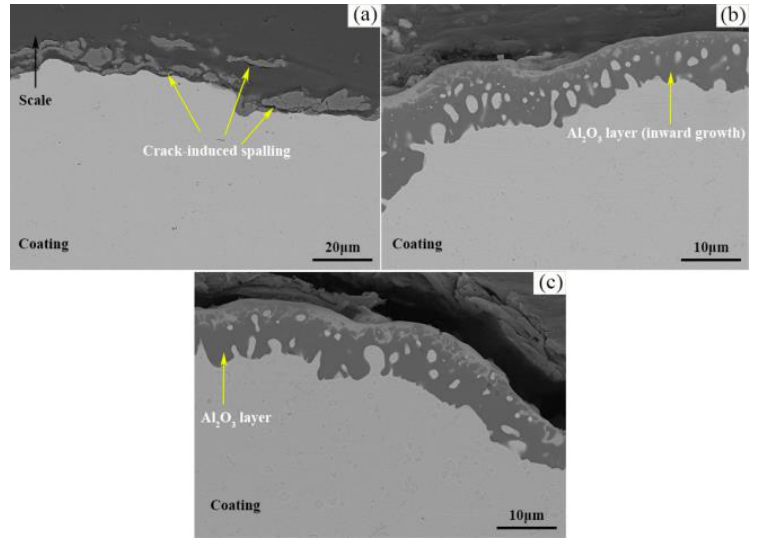
Figure 3. SEM images of TS ( a ) NiCrAl; ( b ) NiCrAl0.5Y and ( c ) NiCrAl1.0Y coatings after oxidation at 1100 ° C for 100 h.